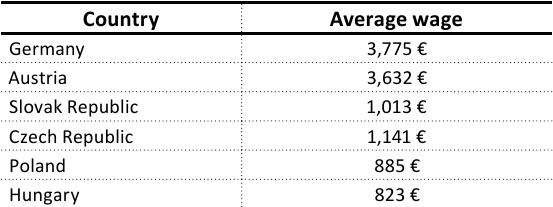
Table 2. Wages in selected countries in the EU Source: Own elaboration according to https://tradingeconomics.com Country